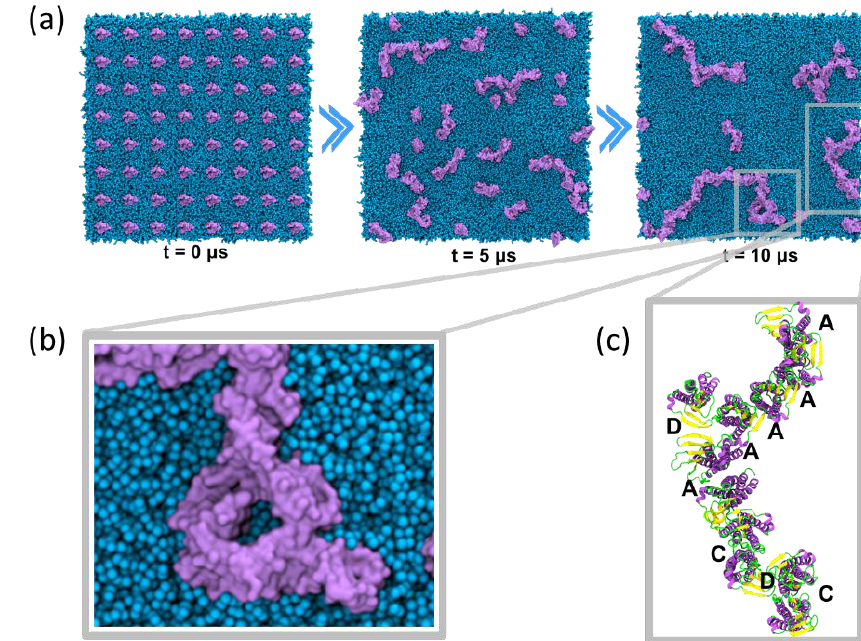
Figure 6. Claudin-5 strand formation in coarse-grain molecular dynamics (CG MD) self-assembly simulations. ( a ) Snapshots (top view) of claudin-5 (purple beads) assembly in lipid (cyan beads) membrane at t = 0, 5, and 10 µs, ( b ) close up view of a self-assembled claudin-5 pentamer, and ( c ) reversed-mapped strand showing dimer A, C, and D conformations.